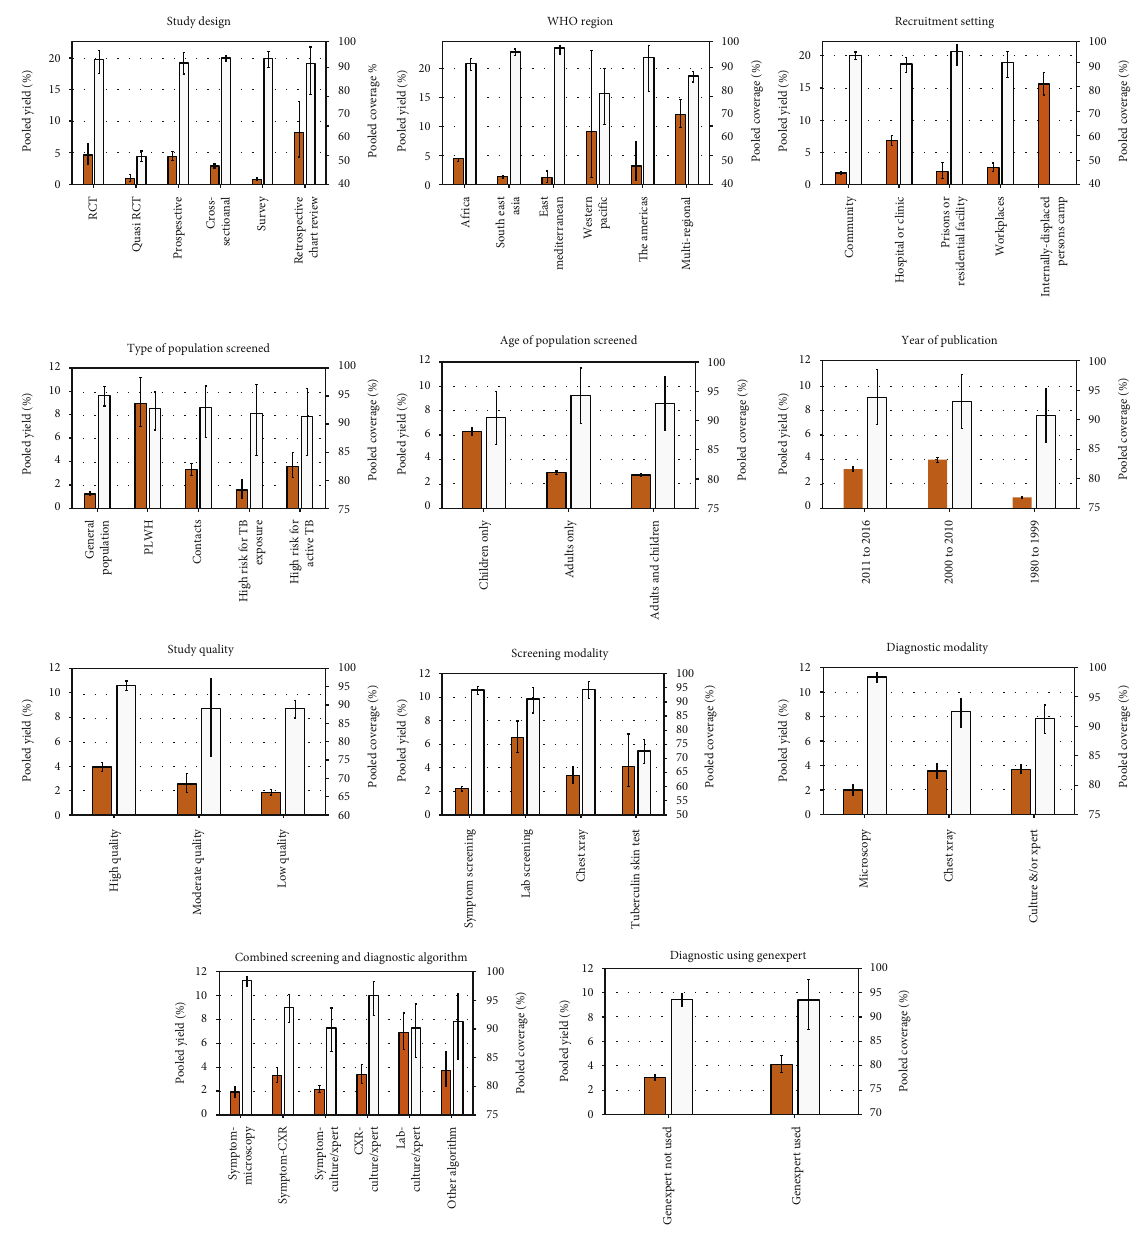
Figure 3: Pooled Estimates of Yield and Coverage by Study and Population Attributes; Coverage is de fi ned as total number of people of screened/total number of people targeted for screening. Yield is de fi ned as total number of people with active TB/total number of people screened. Bars indicate 95% con fi dence intervals of random e ff ects